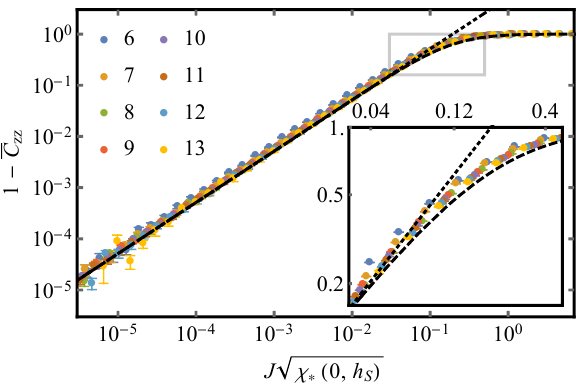
Figure 10: Infinite time correlations : The infinite time spin correlations C are plot- zz ted for the Spin-ETH model. The predicted theoretical form (black dashed) crosses → 1 as J → 0 to C → 0 as J (cid:112) χ ( 0, hp ) (cid:29) 1. The small J asymp- over from C (cid:63) zz zz tote (95) is also shown (black dotted). The theoretical forms show good agreement with numerically extracted values (coloured solid lines, L values on legend, inset). The region enclosed within the grey box where C crosses over between its limit- zz ing values is shown (plot inset). N = 1000,100,10 realisations per data point for L = 11,12,13 repsectively and N = 3000 for L ≤ 10. (solid colours),. These trajectories track the FGR prediction (89) at early times (black dashed) before converging to the ensemble averaged infinite time value (dashed colour). The conver-